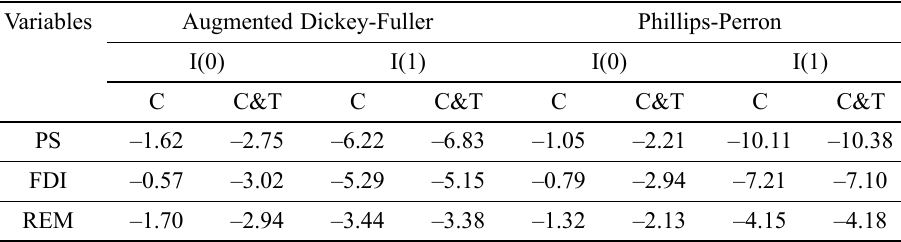
Table 2. Stationary test results